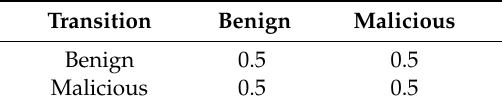
Table 3. Initial transition matrix.